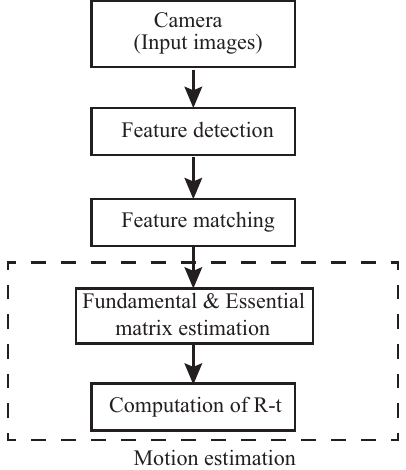
Figure 3. Main components of